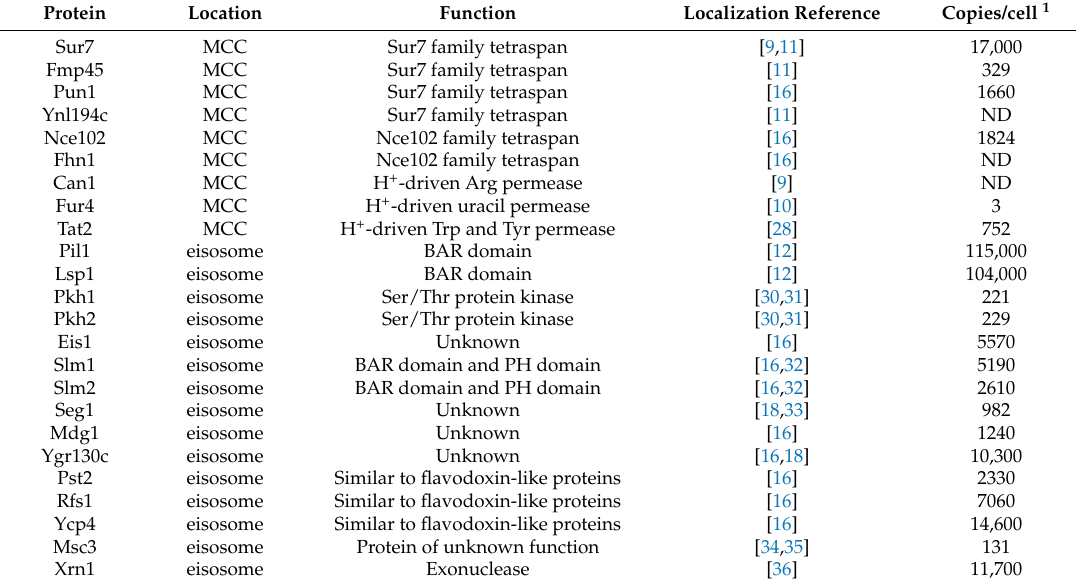
Table 1. S. cerevisiae MCC/eisosome